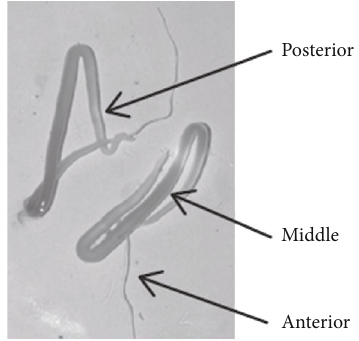
Figure 1: Silk gland morphology in Bombyx mori